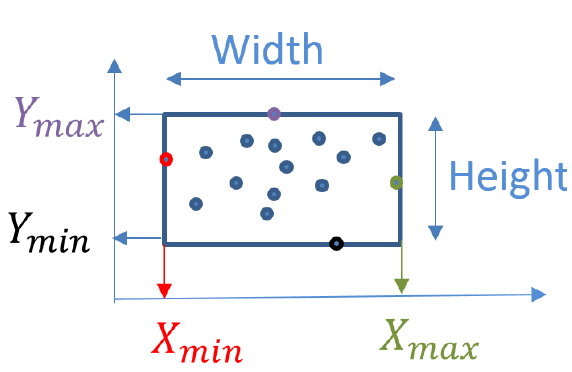
Figure 7. Varying bounding box coordinates.